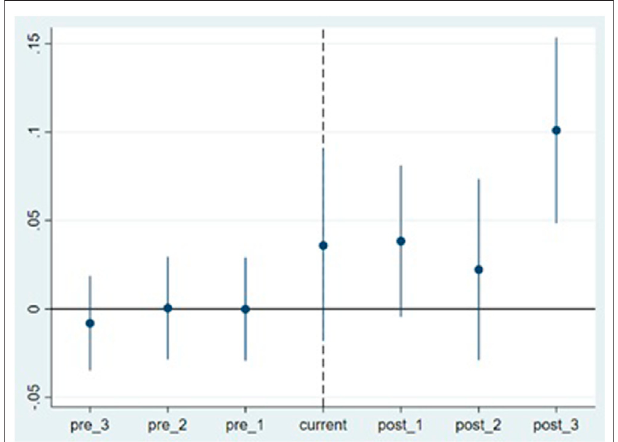
FIGURE 3 | Result of dynamic effect of parallel trend test.